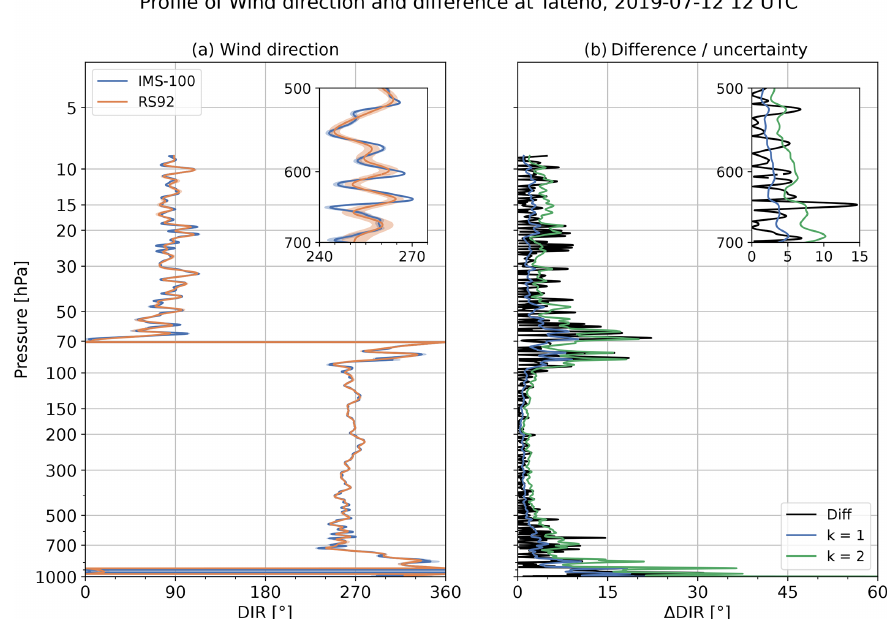
Figure 32. As per Fig. 31 but for wind direction. The differences in wind direction are calculated as the angle between the wind vectors for both GDPs, which is not considered to be